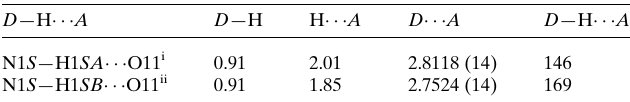
Table 2 Hydrogen-bond geometry (A˚ , (cid:4) ) for 2 .